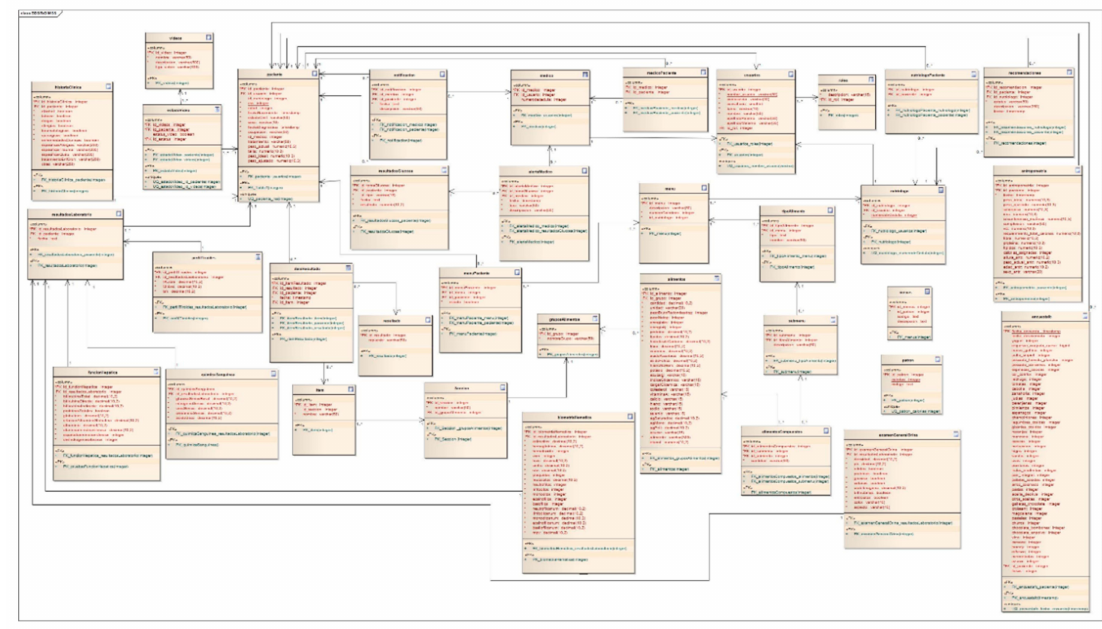
Figure 7. Data model of the proposed